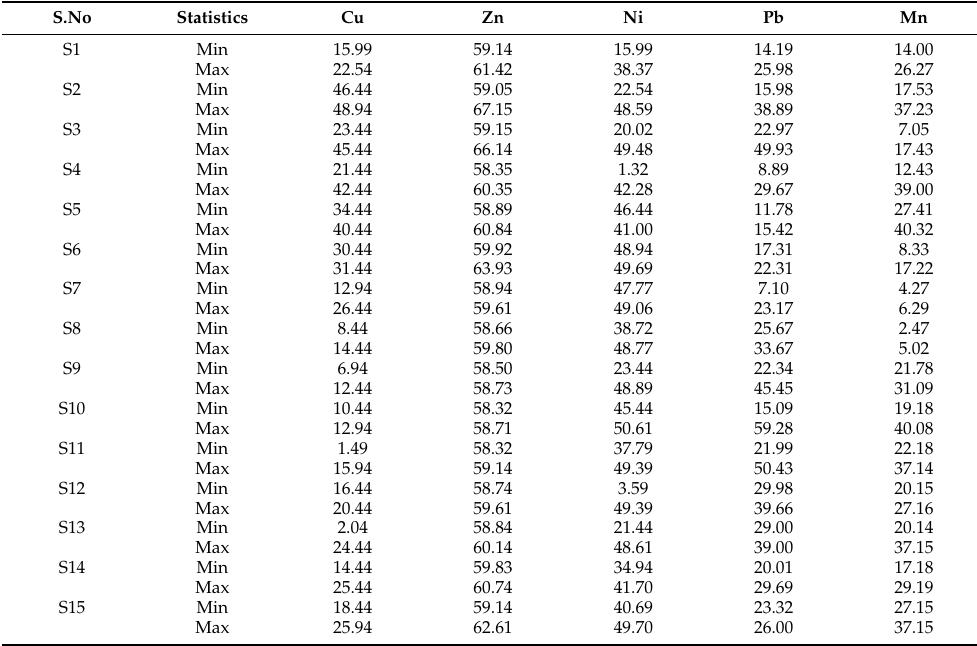
Table 1. Heavy metals concentration (mg/kg) in soil